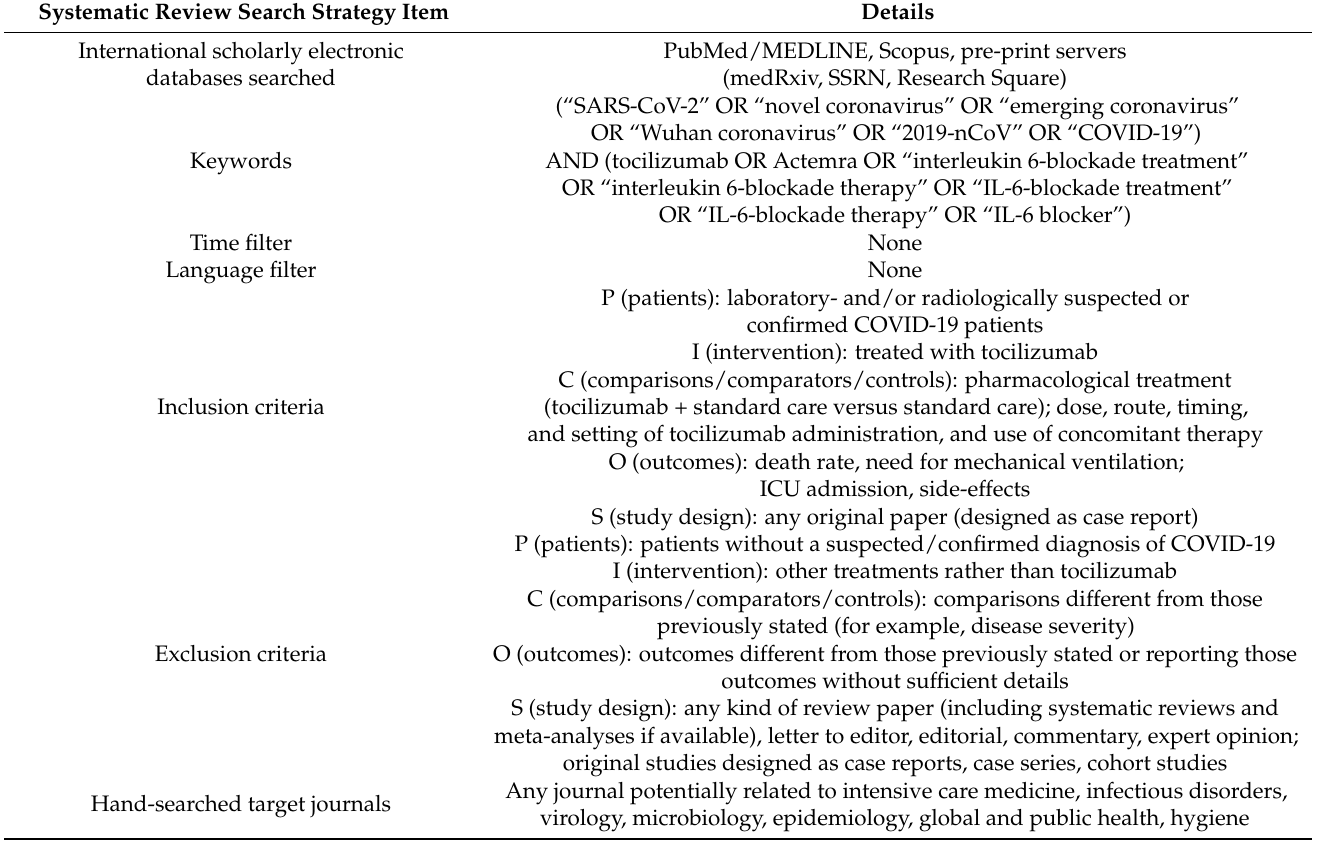
Table 1. Details of the search strategy adopted in the present systematic review and